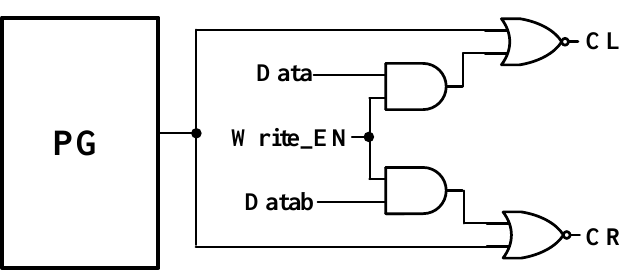
Figure 2. Pulse control read-assist and write data-aware schemes.